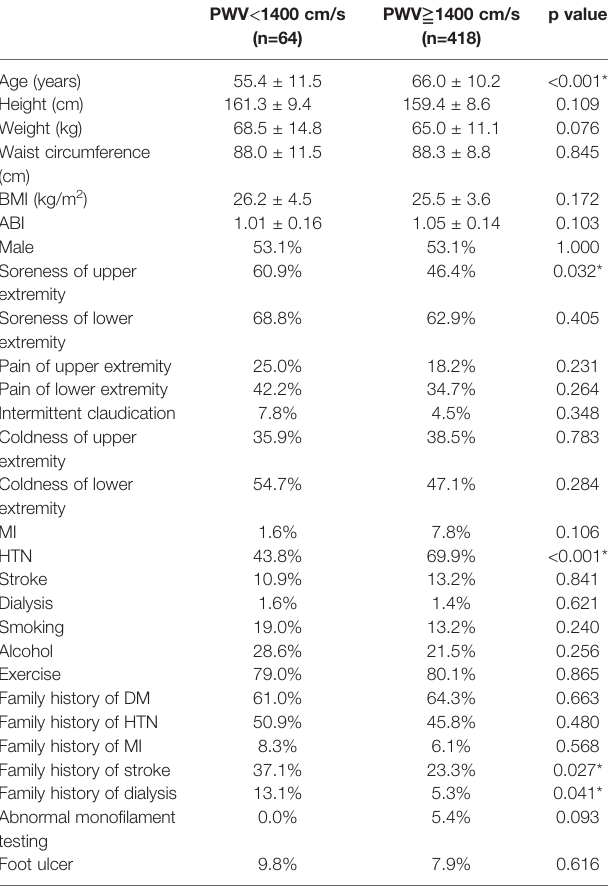
TABLE 5 | Variables in patients with high PWV (PWV ≧ 1400 m/s) versus patients with normal PWV (PWV<1400 m/s). PWV ＜ 1400 cm/s